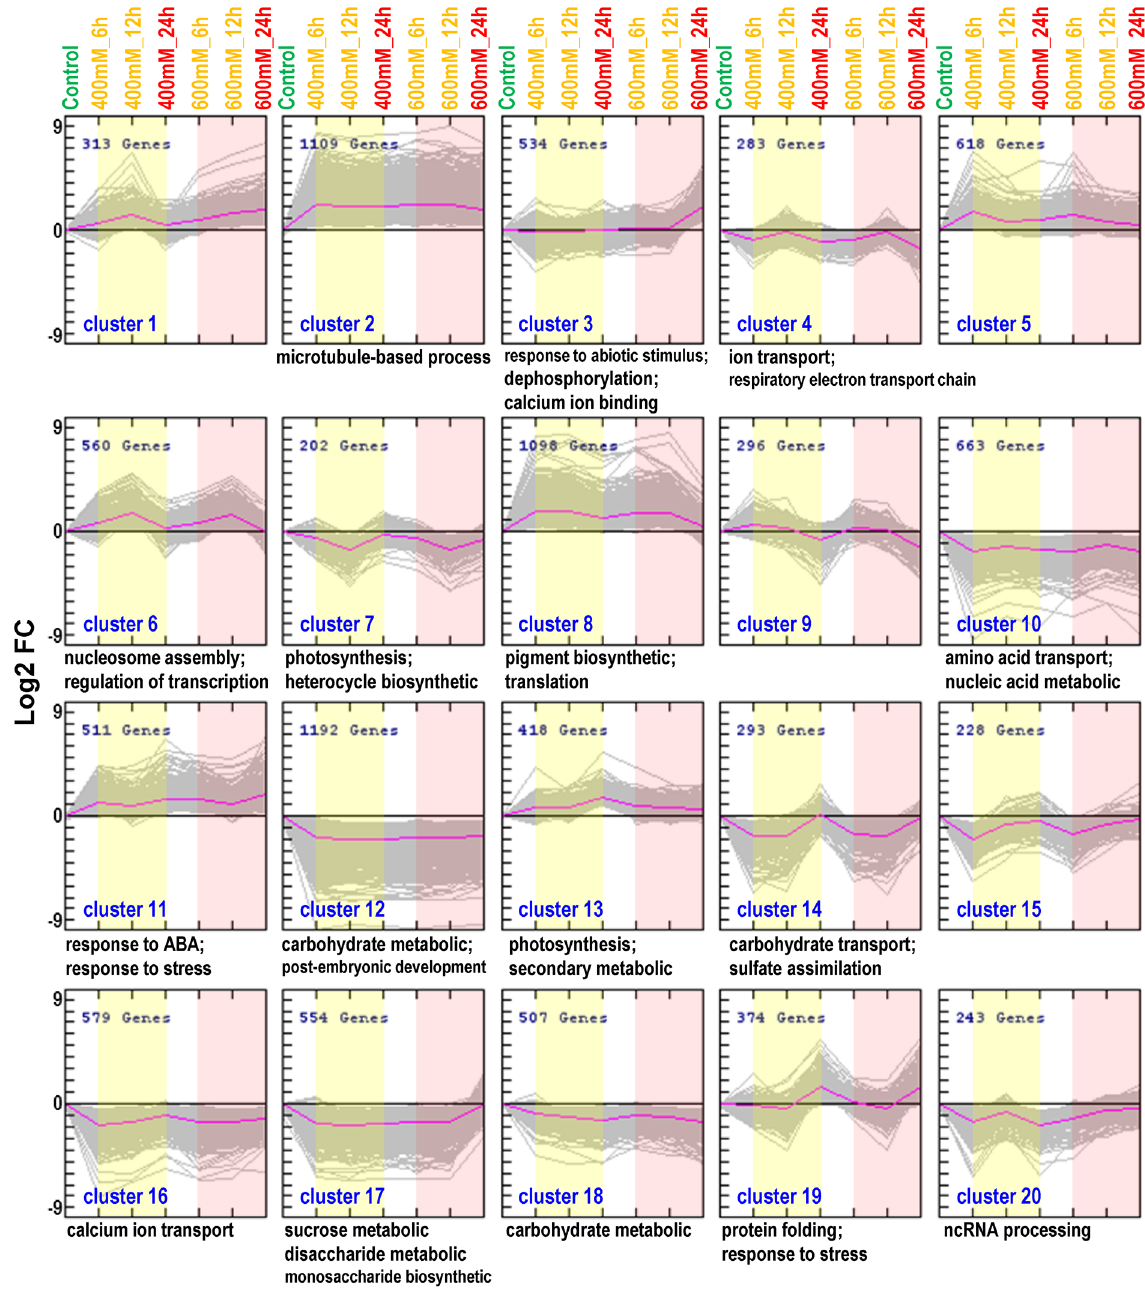
Figure 4. K-means clustering of DEGs in P . euphratica response to salt stress (K = 20 clusters). GO enrichments of DEGs in the 20 clusters are shown in Supplementary Table